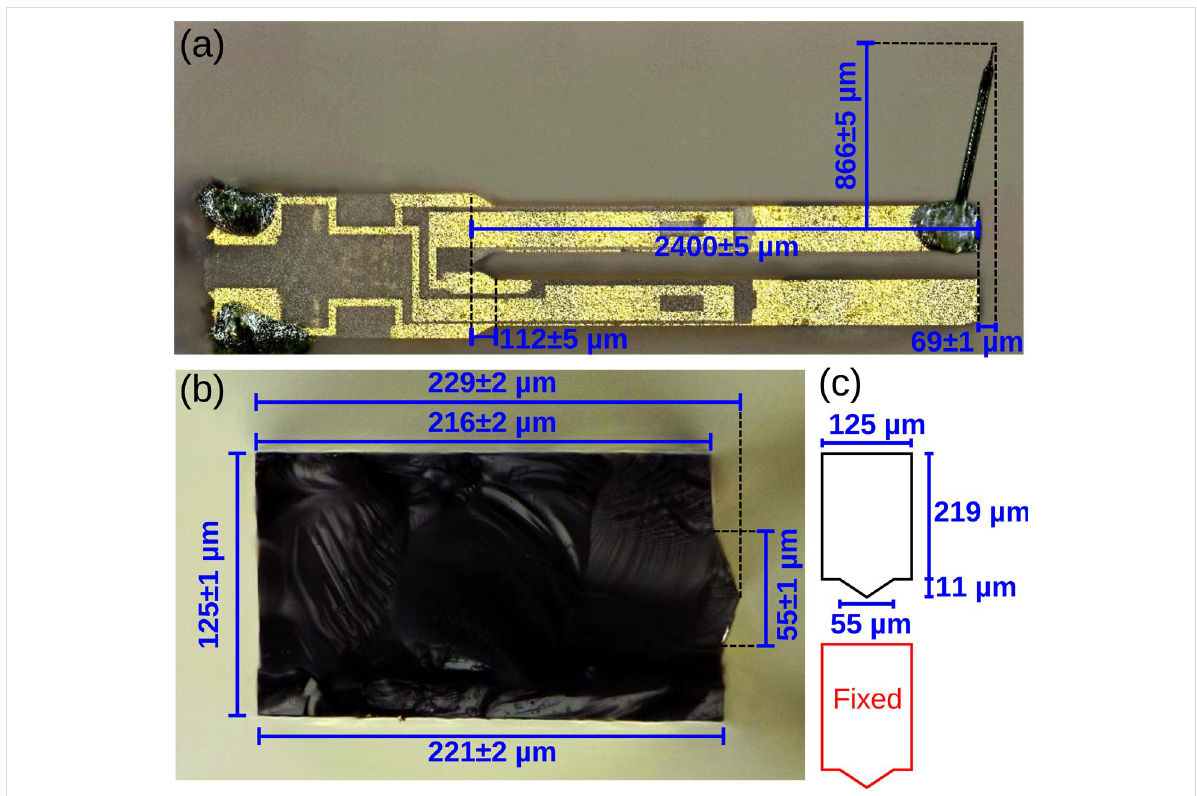
Figure 1: Optical images of a commercial qPlus sensor [8]. (a) Plane-view image consisting of an E158 quartz tuning fork (Micro Crystal, Switzerland) that is glued to a ceramic mount such that one tine is immobilized. A tungsten wire tip is attached to the distal end of the unconstrained tine. The tip height (measured from the center of the beam) is h = 866 ± 5 μ m. The tip also extends the length of the cantilever by 69 ± 1 μ m. (b) Optical image of a cleaved E158 tine showing the non-rectangular cross-section (image is a composite of nine images at slightly different focal lengths). (c) Model schematic of the tine cross-section.